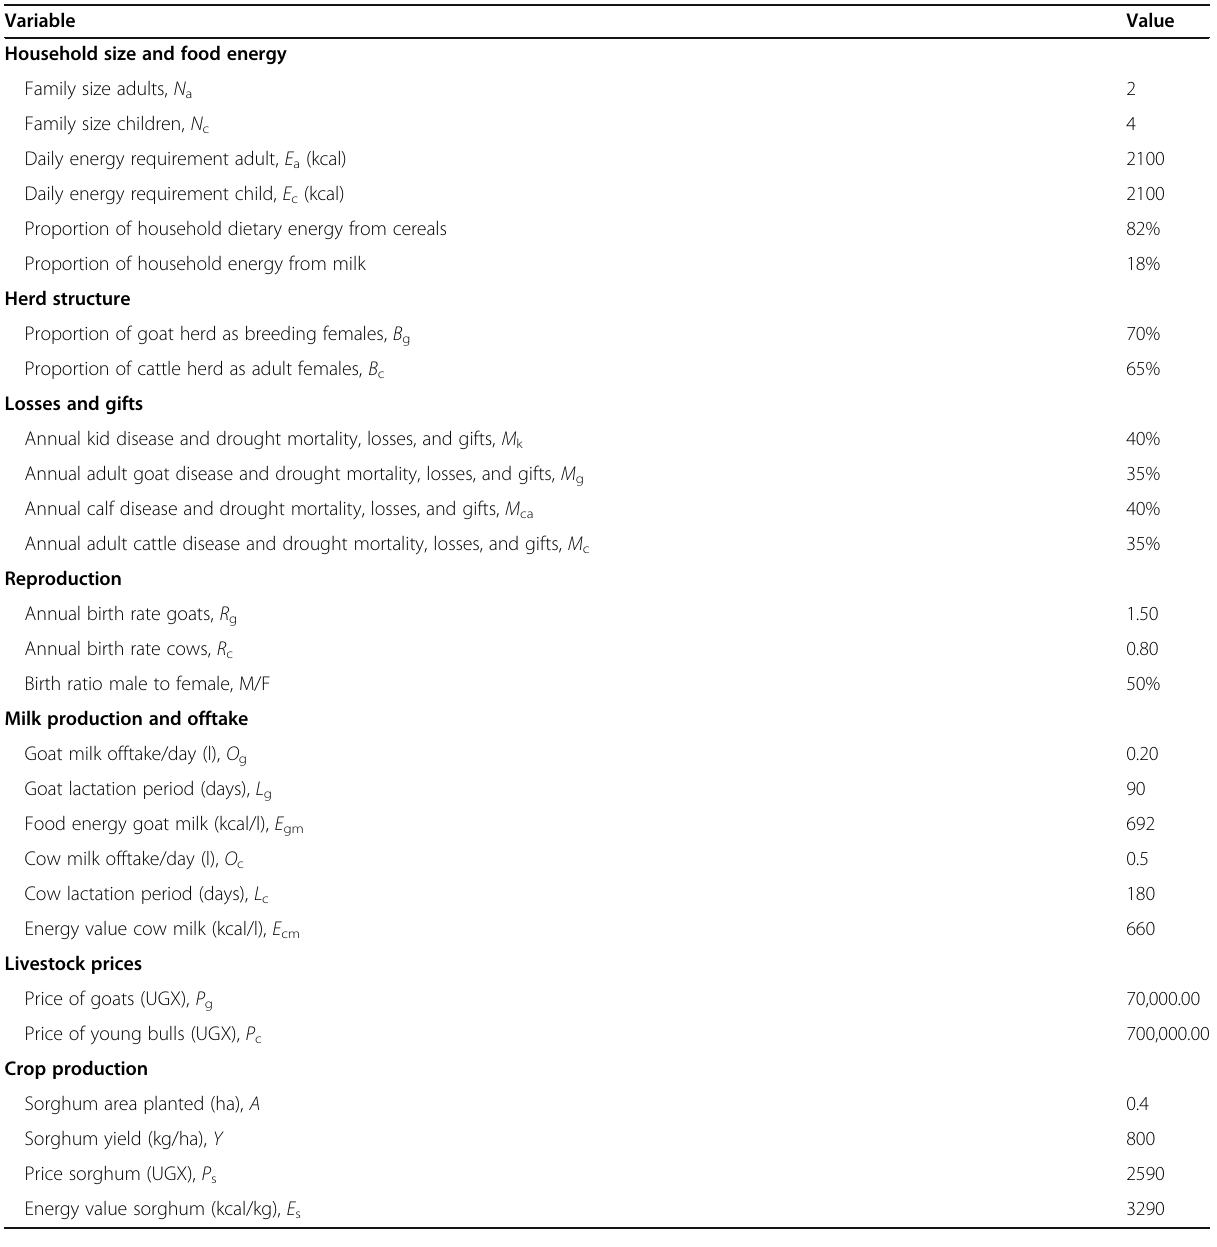
Table 2 Input variables and values for the livestock threshold